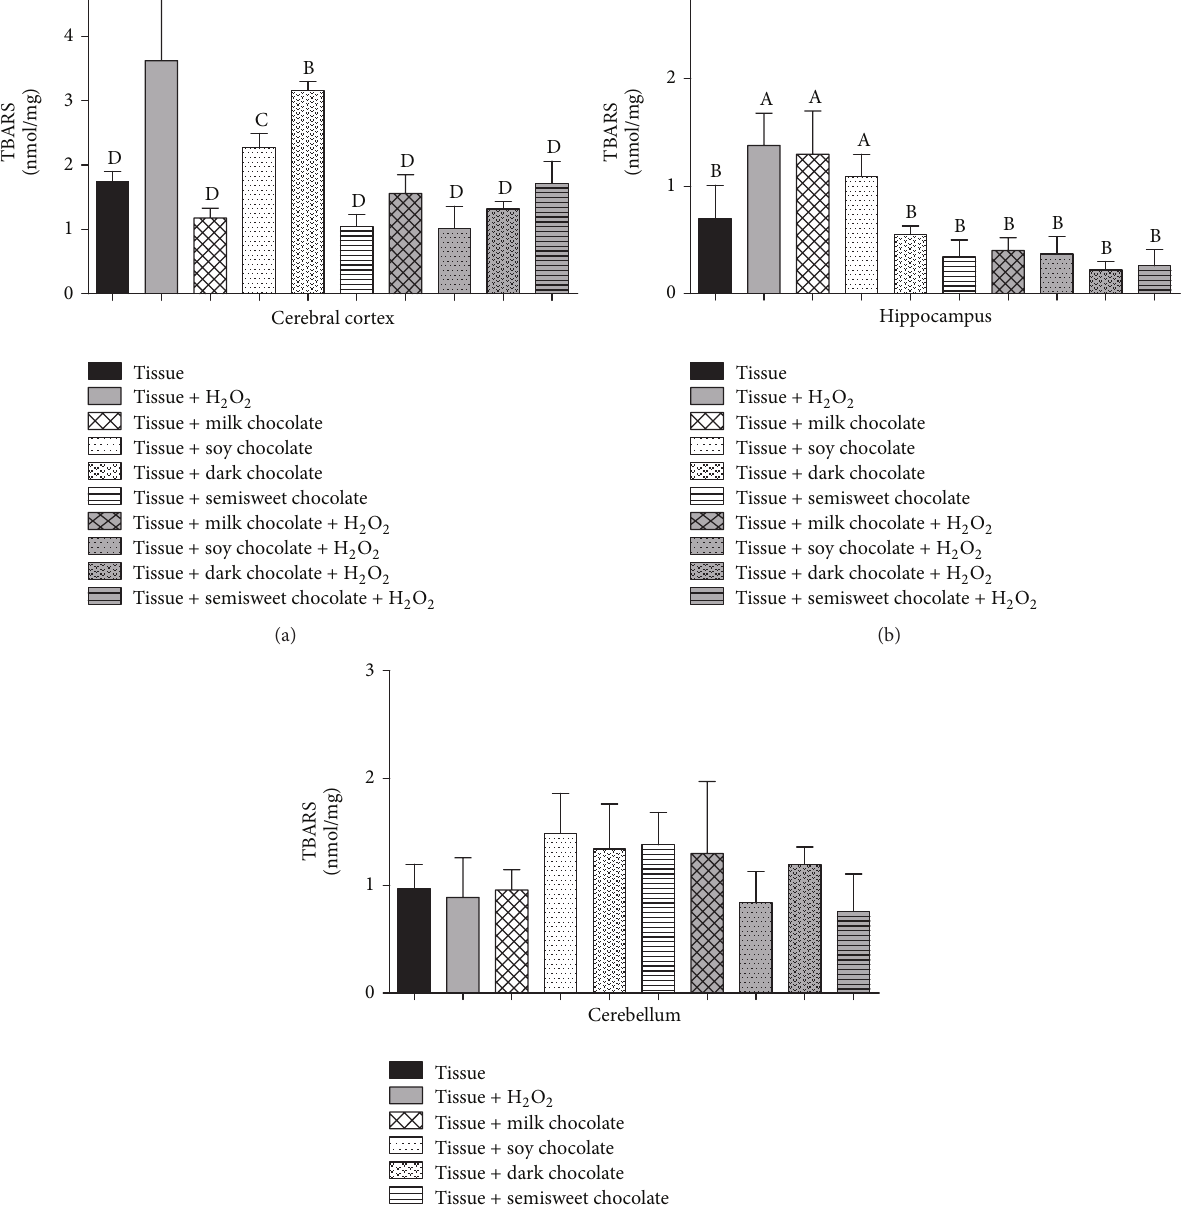
Hermann et al. [25] where the consumption of dark chocolate caused an increased plasma antioxidant capacity concomitant with improved vasodilation in young smokers, confirming the role of chocolate flavonoids in reduction of